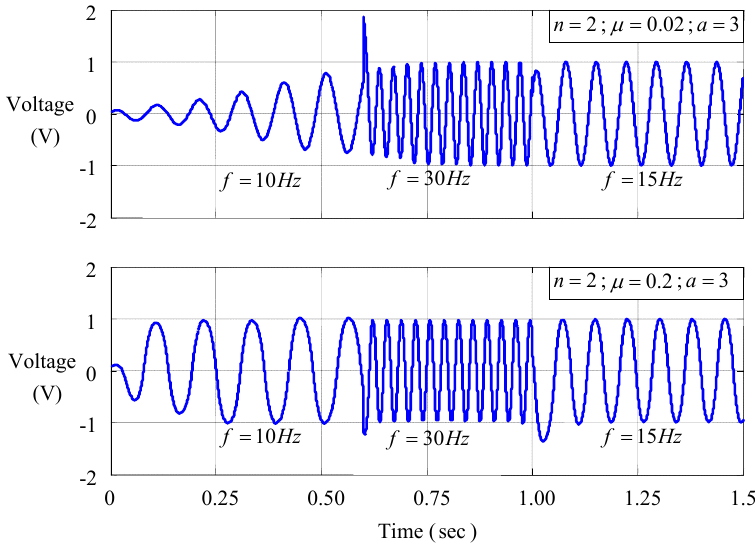
Figure 2. Frequency-modulation with the DSP-based HD-VDP signal